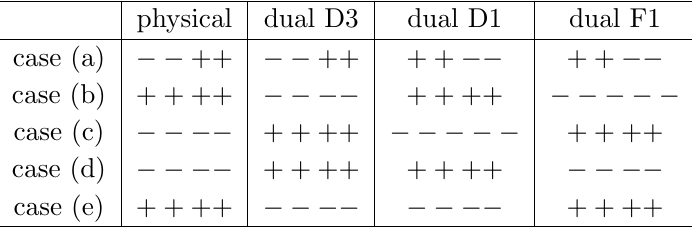
Table 10 . The action of the Z 2 on the extended coordinates Y M